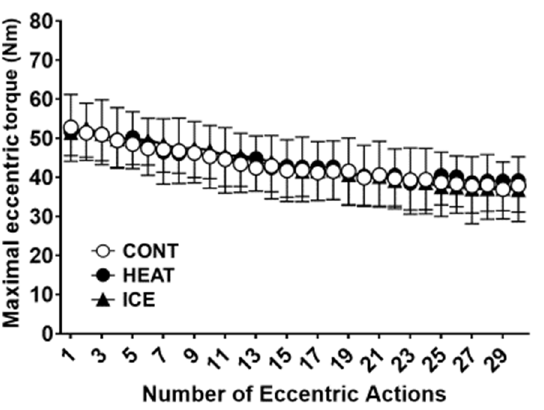
Figure 3. Changes in the elbow flexion torque (mean ± SD of 14 participants) over 30 maximal voluntary eccentric contractions.